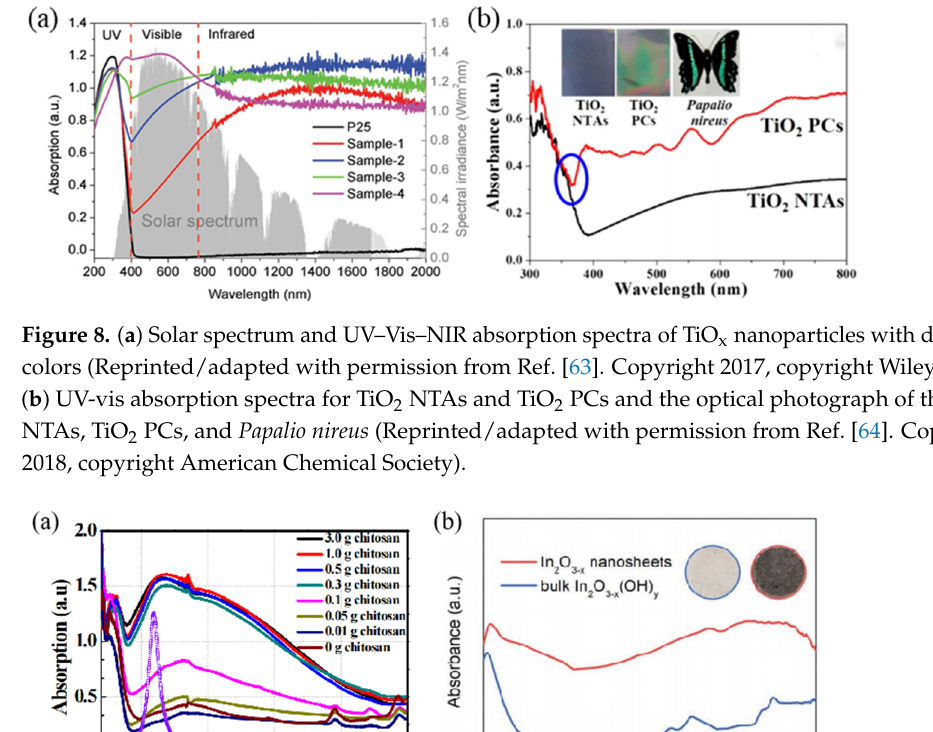
2 absorbs approximately 65% of